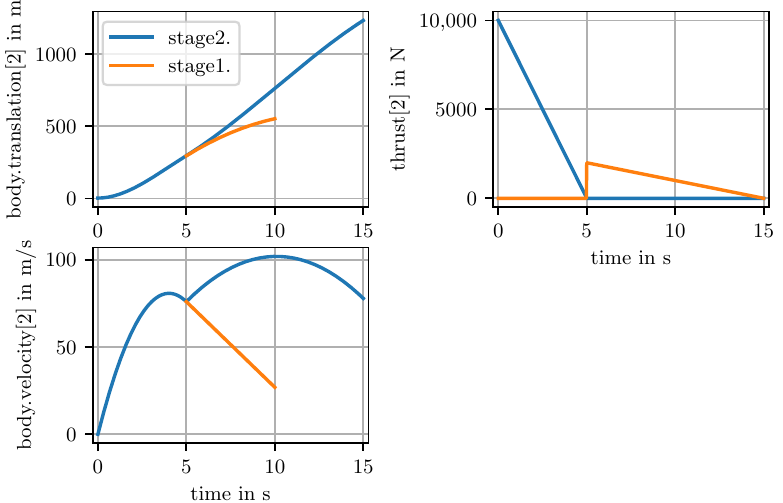
Figure 11. Plots of relevant variables from the simulation of model TwoStageRocket of Listing 7. Variable values are not shown in the plots, if they are not defined in the respective